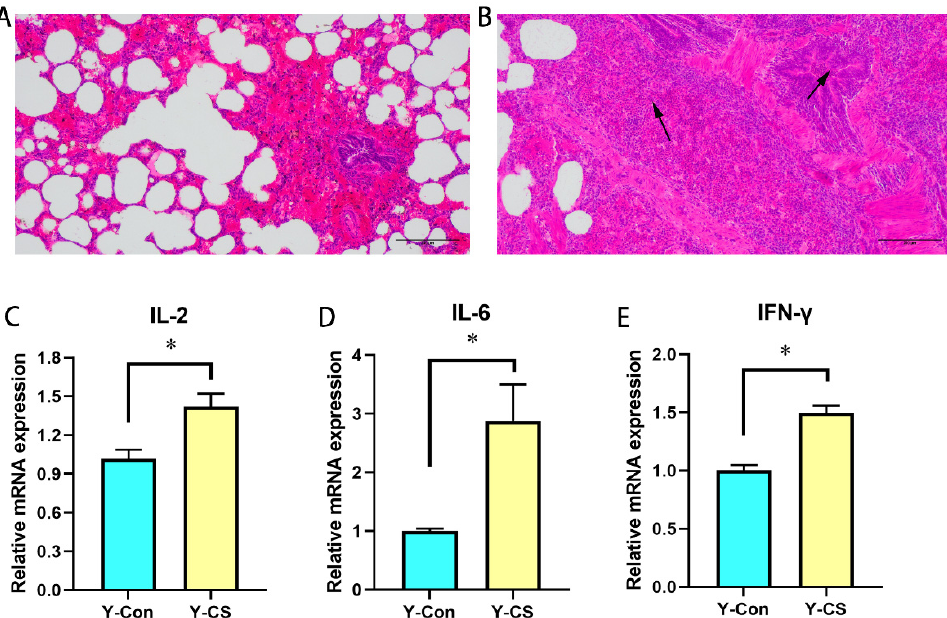
Figure 1. Lung injury assessment and inflammatory cytokines. ( A ) Hematoxylin and eosin (HE) in lung tissue of the control group (Y-Con). ( B ) HE in lung tissue of the cold stress group (Y-CS). Black arrows indicate inflammatory cell infiltration or abnormal development. ( C ) IL-2 mRNA expression in lungs. ( D ) IL-6 mRNA expression in lungs. ( E ) IFN- γ mRNA expression in lungs. Data are expressed as the mean ± SEM, n = 6, * p < 0.05.